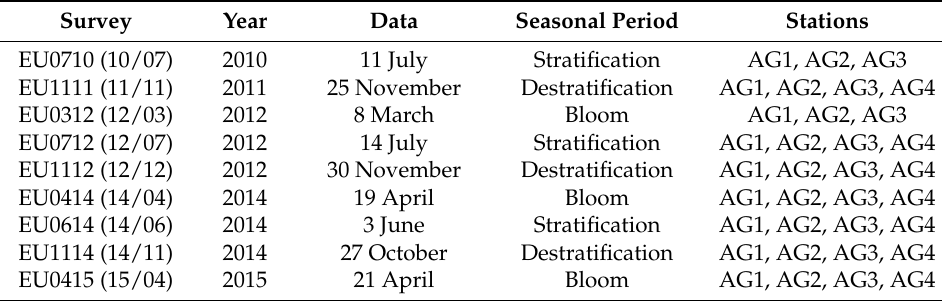
Table 1. Sampling dates and stations in the Bay of